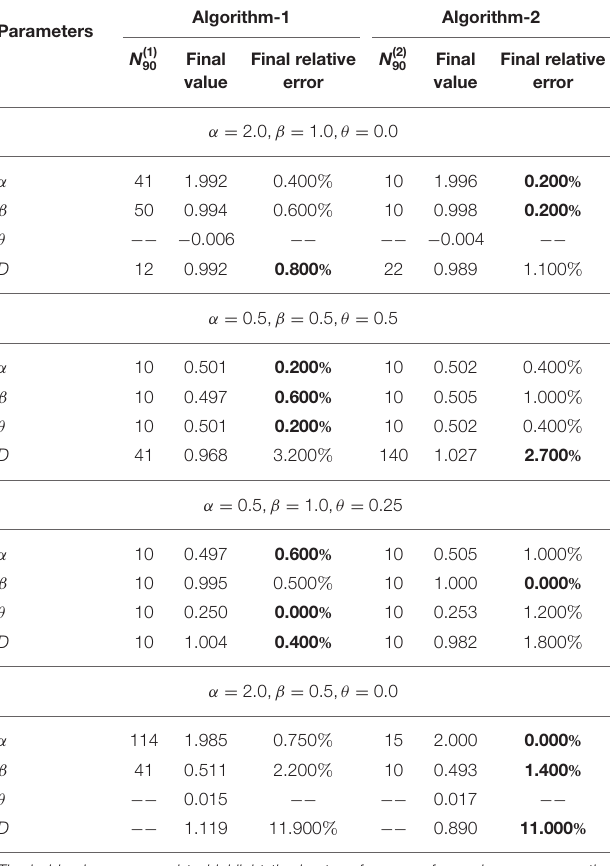
TABLE 1 | Numerical results for fractional diffusion parameter estimation with D 1. =